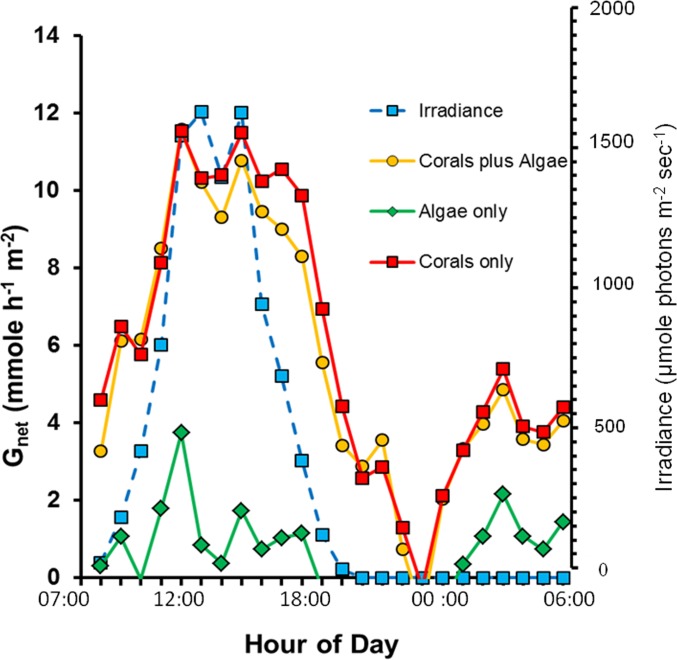
Diurnal net calcification rate (Gnet) and irradiance for the three mesocosms.